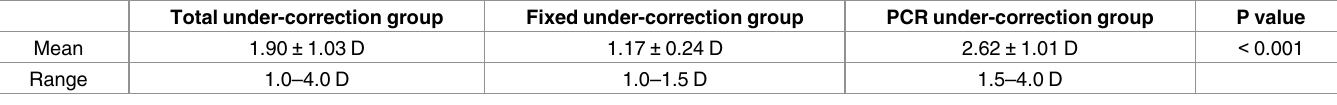
Table 2. The amount of hyperopia reduction with spectacle correction in the under-correction group.